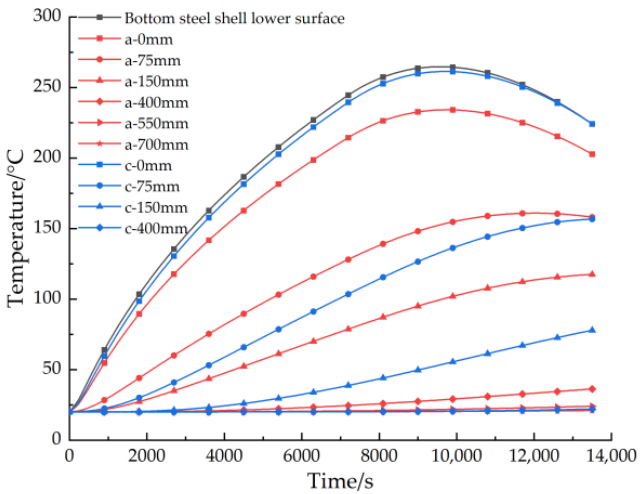
Figure 26. Time-temperature curves of each measuring point in the member under the protection of fireproof board.